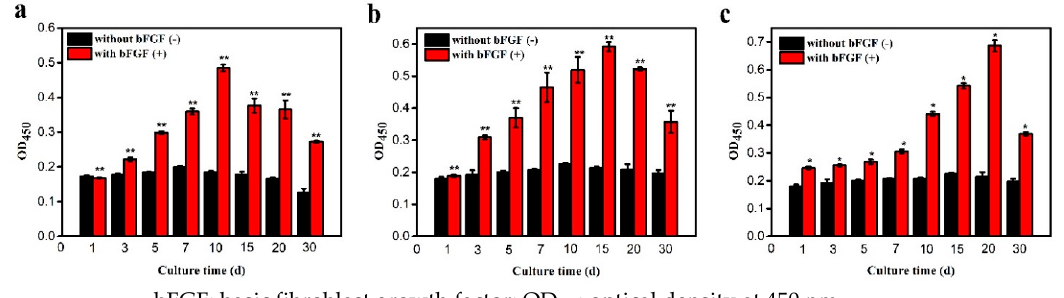
bFGF: basic fibroblast growth factor; OD 450 : optical density at 450 nm Figure 4. Proliferation of artificial cells under different culture conditions: ( a ), Static, ( b ) shaking, and ( c ) RCCS (** p < 0.01, * p <